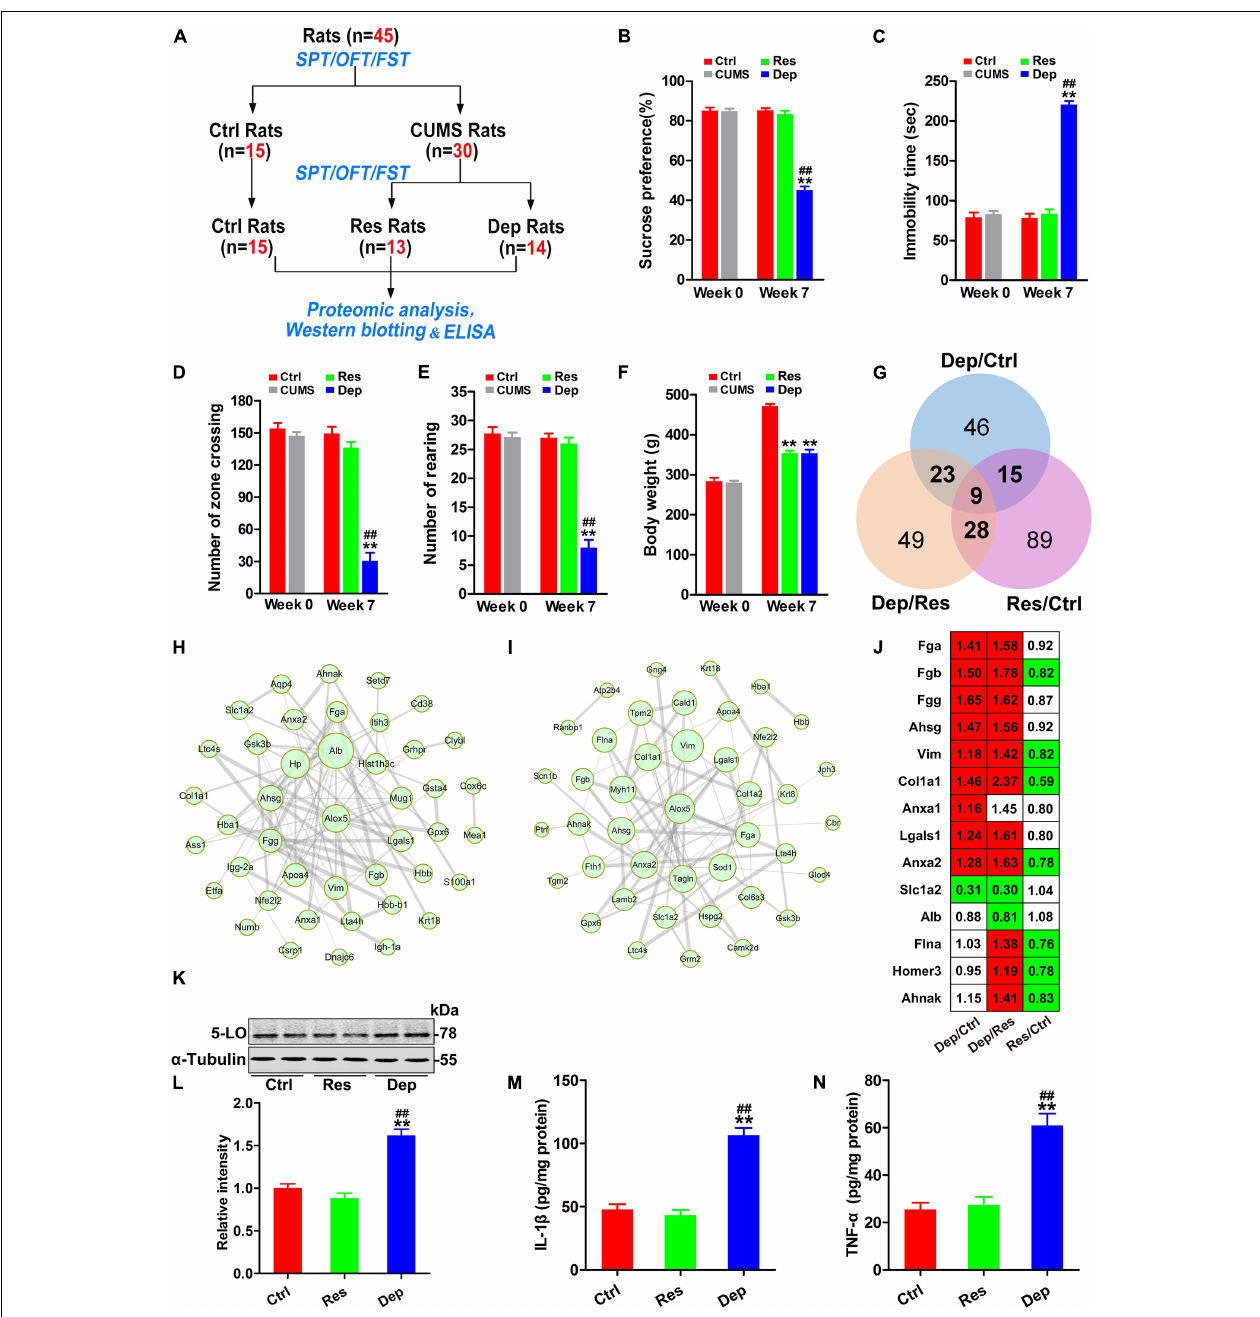
FIGURE 1 | Inflammation with increased 5-lipoxygenase (5-LO) was observed in the hippocampi of Dep rats. Schematic illustration of the first part of this research (A) . Forty-five rats were evaluated by the sucrose preference test (SPT), forced swimming test (FST), and open field test (OFT). Then, 15 rats were randomly chosen as control (Ctrl) rats, and 30 rats were exposed to chronic unpredicted mild stress (CUMS). Seven weeks later, 13 depression resistant (Res) rats and 14 depression (Dep) rats were obtained. The hippocampi of rats were analyzed by proteomic analysis ( n = 3/group), Western blotting ( n = 6/group) and ELISA ( n = 3/group). The sucrose preference rates in the SPT (B) [ F ( 2 , 41 ) = 128.332, p = 0.000], immobility time in the FST (C) [ F ( 2 , 41 ) = 160.933, p = 0.000], numbers of zone crossing (D) [ F ( 2 , 41 ) = 46.218, p = 0.000] and rearing times (E) [ F ( 2 , 41 ) = 57.185, p = 0.000] in the OFT, and the body weights of rats (F) [ F ( 2 , 41 ) = 127.246, p = 0.000] were recorded. Based on the identified differentially expressed proteins (DEPs) (G) , protein–protein interaction (PPI) networks of the DEPs in Dep/Ctrl rats (H) and Dep/Res rats (I) were constructed. The thickness of edges was decided by the combined score. The DEPs related to inflammation were listed with a ratio ( J , red color means significant up-regulation and green color means significant down-regulation). Hippocampal levels of 5-lipoxygenase (5-LO) (K,L) [ F ( 2 , 15 ) = 42.049, p = 0.000], interleukin-1 β (IL-1 β , M ) [ F ( 2 , 15 ) = 53.947, p = 0.000] and tumor necrosis factor- α (TNF- α , N ) [ F ( 2 , 15 ) = 27.079, p = 0.000] in the Ctrl, Res, and Dep rats were tested by Western blotting (K,L) and ELISA (M,N) . Data were analyzed by a one-way ANOVA with LSD post hoc test and expressed as the means ± S.E.M. ** p < 0.01 Res or Dep versus Ctrl. ## p < 0.01 Dep versus Res.